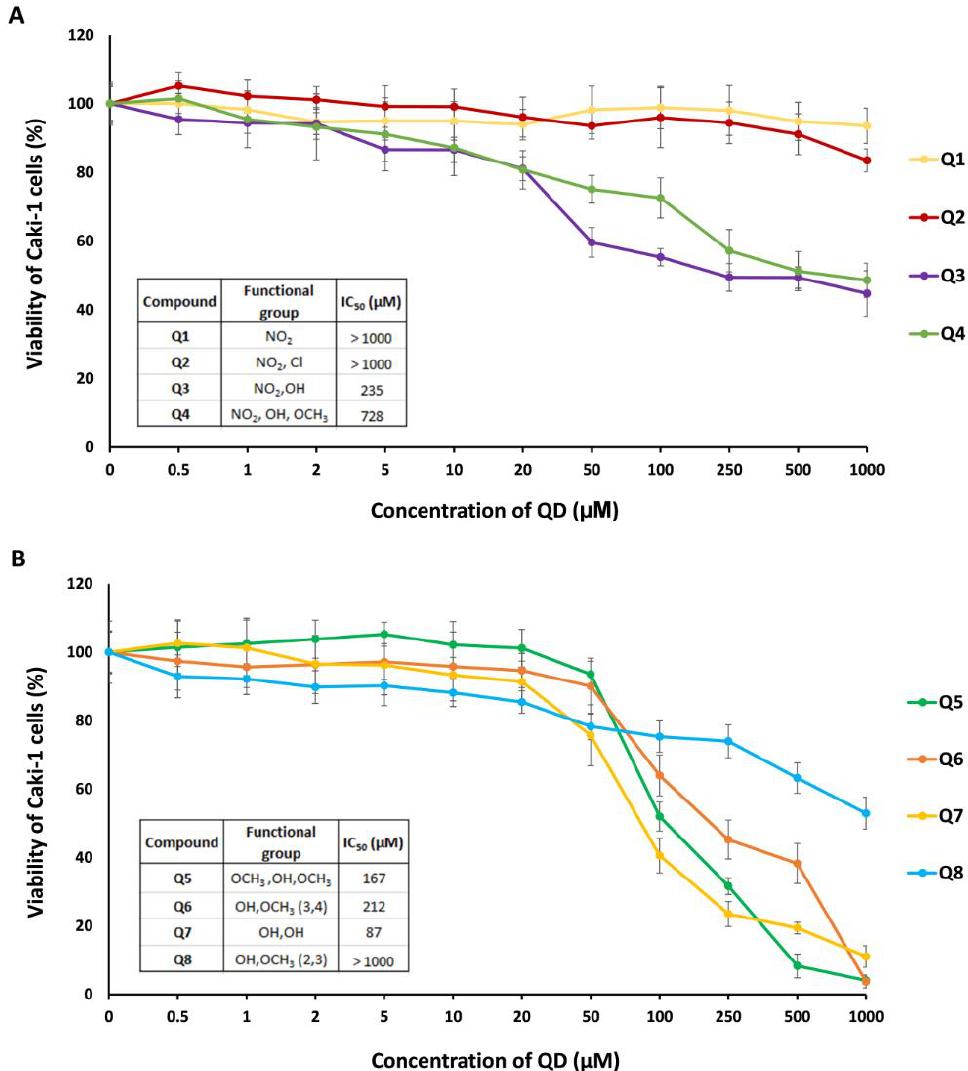
Figure 3. The cytotoxic effects of studied quinazolinones on Caki-1 cell viability after 24 h incubation; compounds Q1–Q4 ( A ); compounds Q5 – Q8 ( B ).